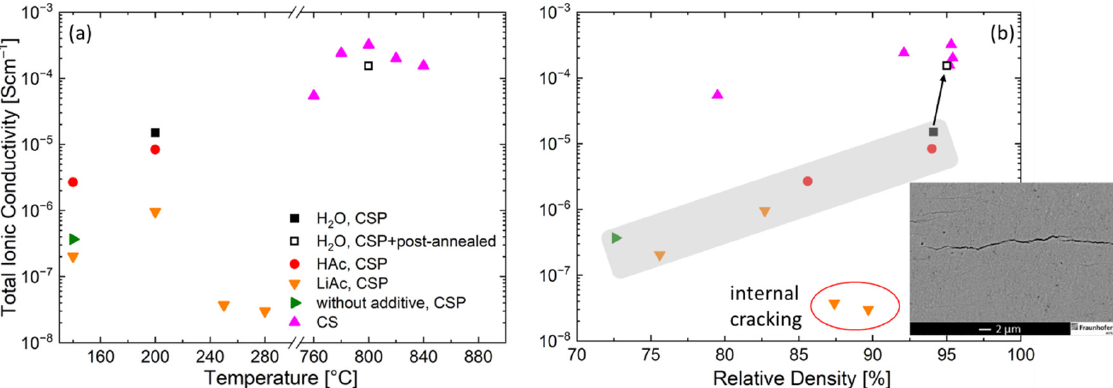
Figure 4. Total ionic conductivity of the LATP samples prepared by conventional pressureless sintering (CS) and cold sintering process (CSP) using liquid and solid sintering additives as a function of ( a ) the peak sintering temperature and ( b ) the relative density of the samples. Inset in ( b ): micrograph of the LATP ceramics prepared by cold sintering process at peak temperature of 280 °C using LiAc solid additive.